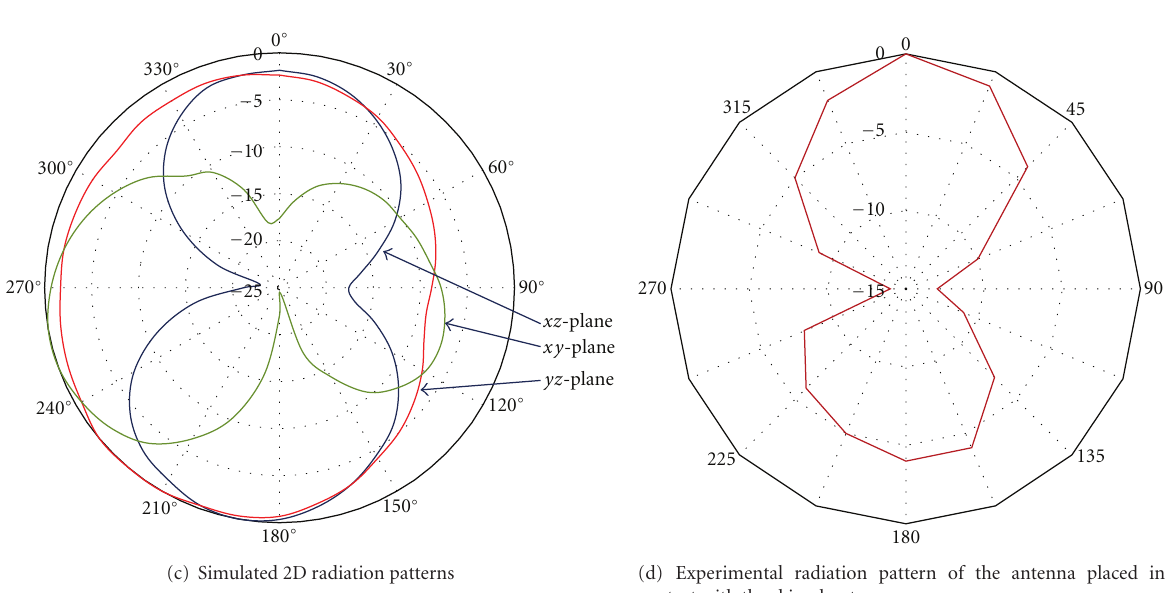
Figure 4: Experimental and simulation results of the antenna placed in contact with the